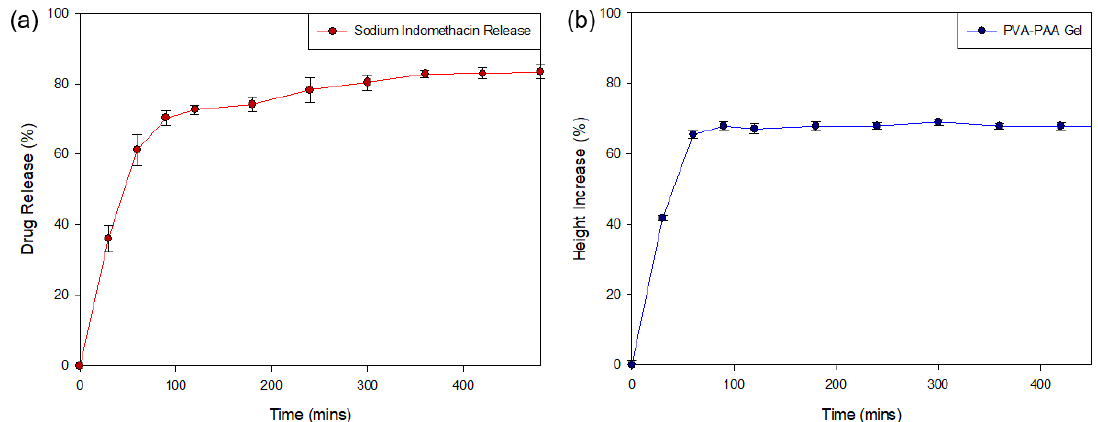
Figure 10. Drug release profile of ( a ) sodium indomethacin from the PPP scaffold (SD ≤ 4.36% in all cases) with ( b ) the change in height of the PVA–PAA hydrogel in response to exposure to simulated drug release media (0% representing the gel height at time 0 mins; SD ≤ 1.41% in all cases ).